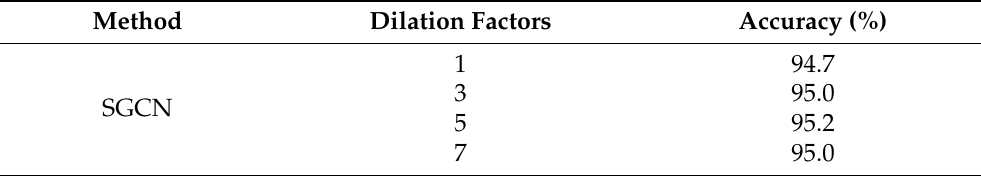
Table 3. Comparisons of validation accuracy of the model with different dilation factors.